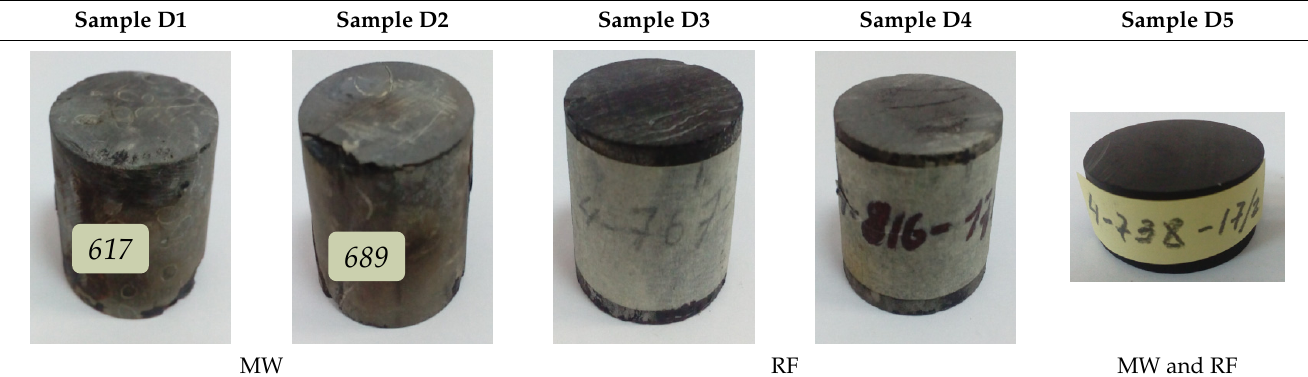
Table 2. The photos of the Domanic Formation samples and type of electromagnetic treatment exposed in the experiments. Sample D1